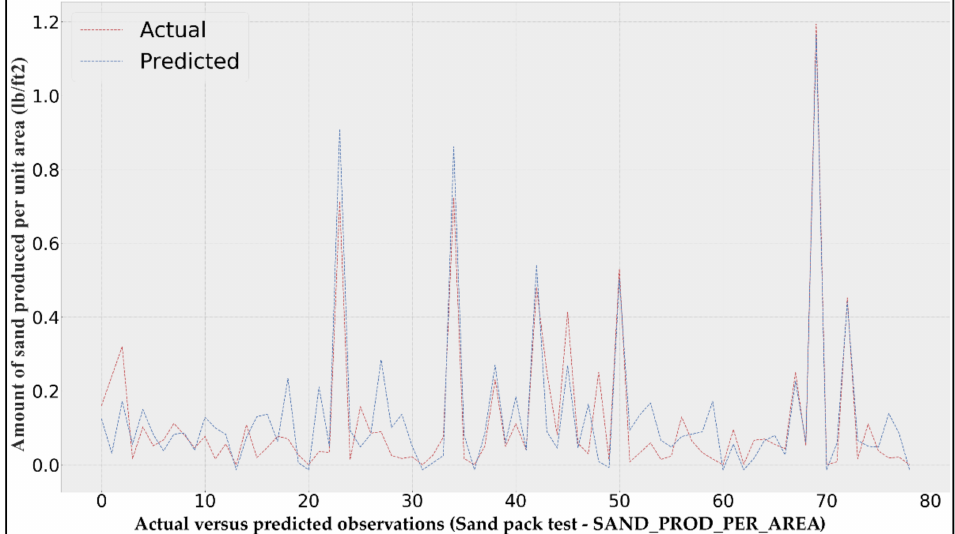
Figure 7. The actual versus predicted plot of model 1 of sand production for the sand pack